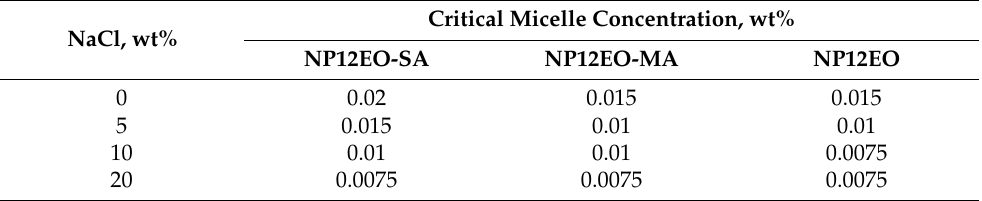
Table 1. CMC of surfactant NP12EO-SA, NP12EO-MA, and NP12EO at different NaCl concentrations. Critical Micelle Concentration, wt% NaCl, wt% NP12EO-SA NP12EO-MA NP12EO 0 0.02 0.015